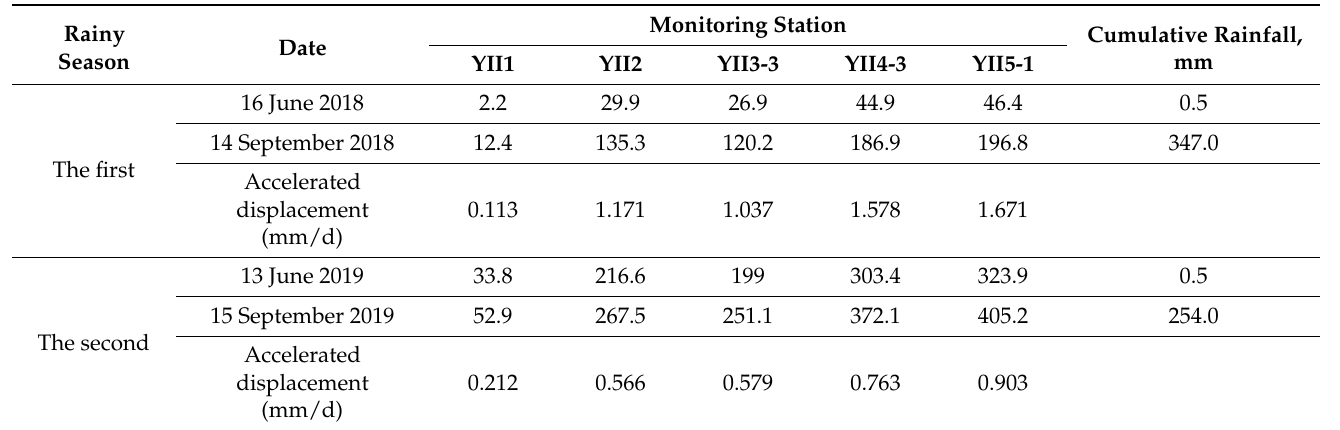
Table 1. Deformation with